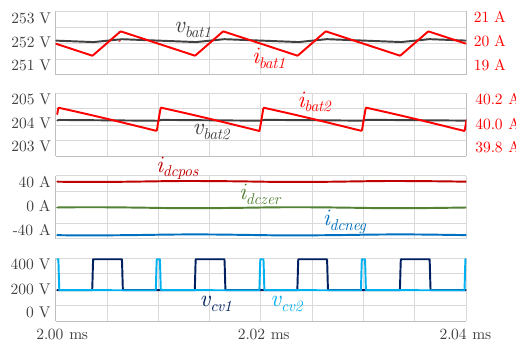
Figure 4. Simulation results of the G2V operation mode when EV1 is charging with a current of 20 A and EV2 is charging with a current of 40 A.